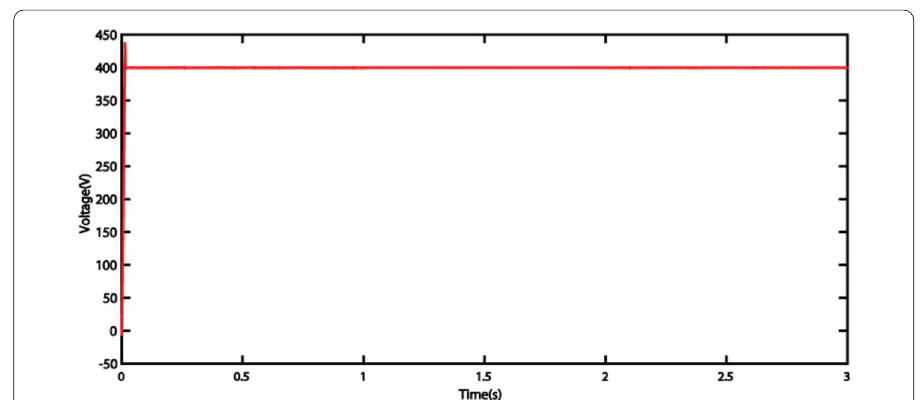
Fig. 15 Voltage at the Bus_DC